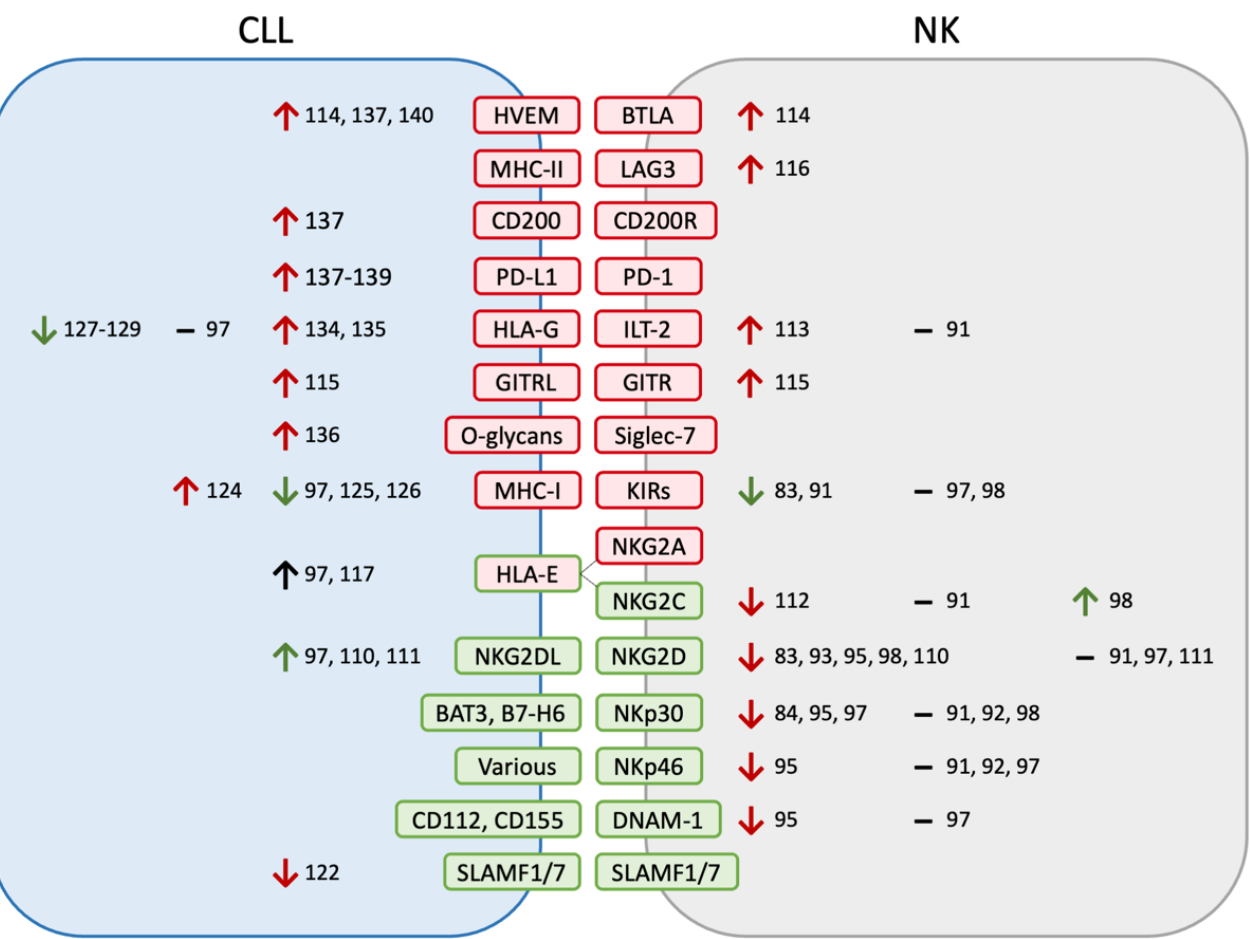
Figure 1. Altered CLL-NK ligand–receptor interactions. Ligand–receptor pairs are color-coded by their activating (green) versus inhibitory (red) effects on NK cells. Changes are listed as increases ( ↑ ), decreases ( ↓ ), or no change (–) and are similarly color-coded according to whether the measured change is expected to increase or decrease NK activation, as well as the relevant citations listed. Different studies have found varying (and, at times, conflicting) changes in ligand and receptor expression levels that broadly point to decreased NK activity against CLL. NKG2DL refers to the ligands of NKG2D (MICA, MICB,